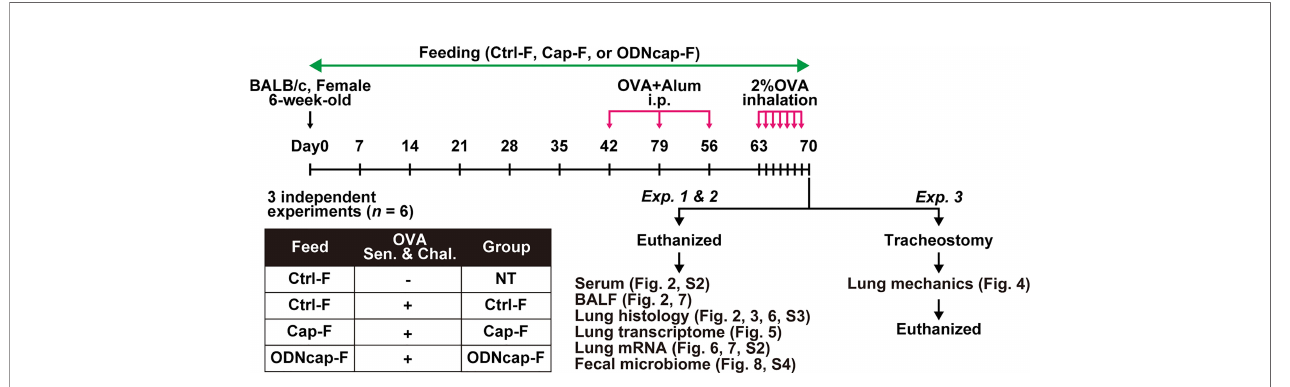
FIGURE 1 | Schematic protocol for the in vivo experiments. OVA, ovalbumin; Alum, aluminum oxide gel; i.p., intraperitoneal injection; Sen. & Chal., sensitization and challenge; Ctrl-F, standard feed; Cap-F, control particle-containing feed; ODNcap-F, CpG-oligodeoxynucleotide particle-containing feed; Exp., experiment; BALF, bronchoalveolar lavage